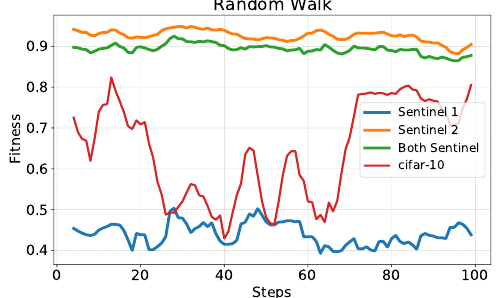
Figure 9. A random walk evaluated with the four different sensor